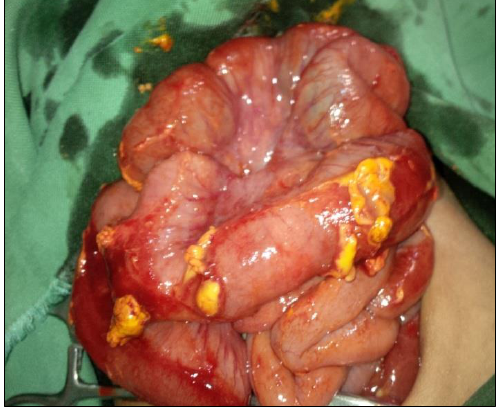
Figure 1: Intraoperative findings showing the ileal